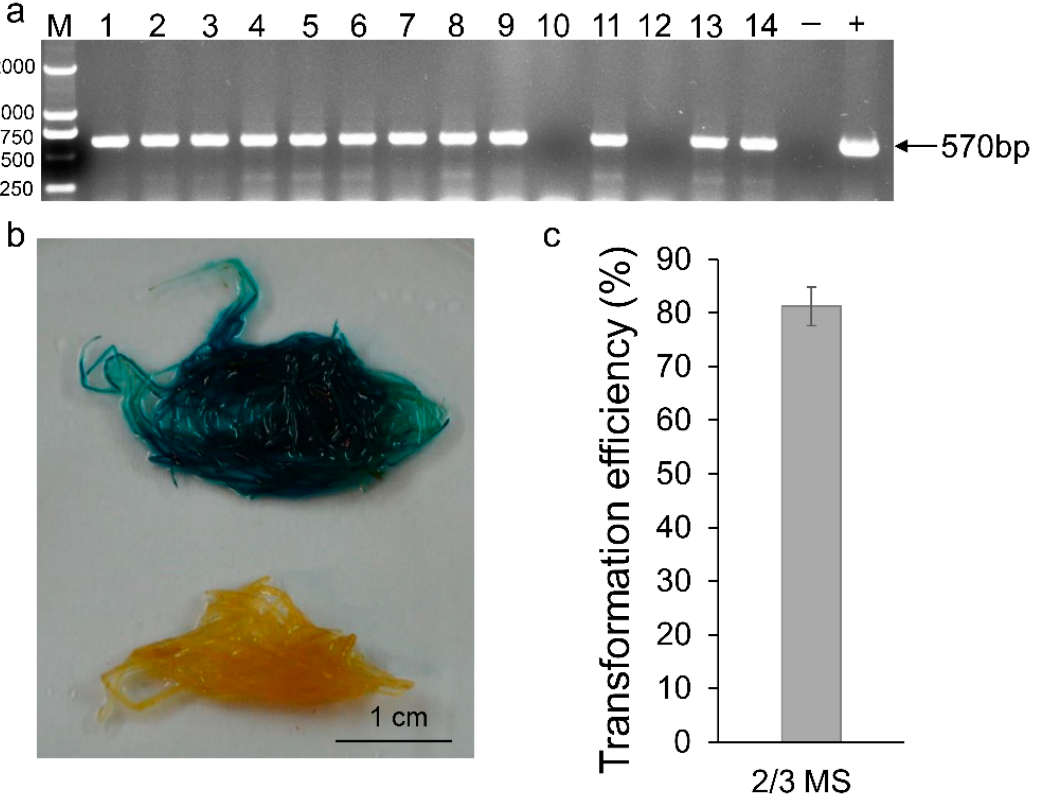
Figure 4. Efficiency of the hairy root transformation by R. rhizogenes strain LBA9402 containing a binary vector pCAMBIA1305.1: ( a ) PCR targeting GUS gene in hairy roots; ( b ) a typical picture showing positive (blue) and negative (brown) GUS staining of the hairy roots; ( c ) efficiency of tobacco hairy root transformation mediated by R . rhizogenes strain LBA9402 cultured on 2/3MS medium.